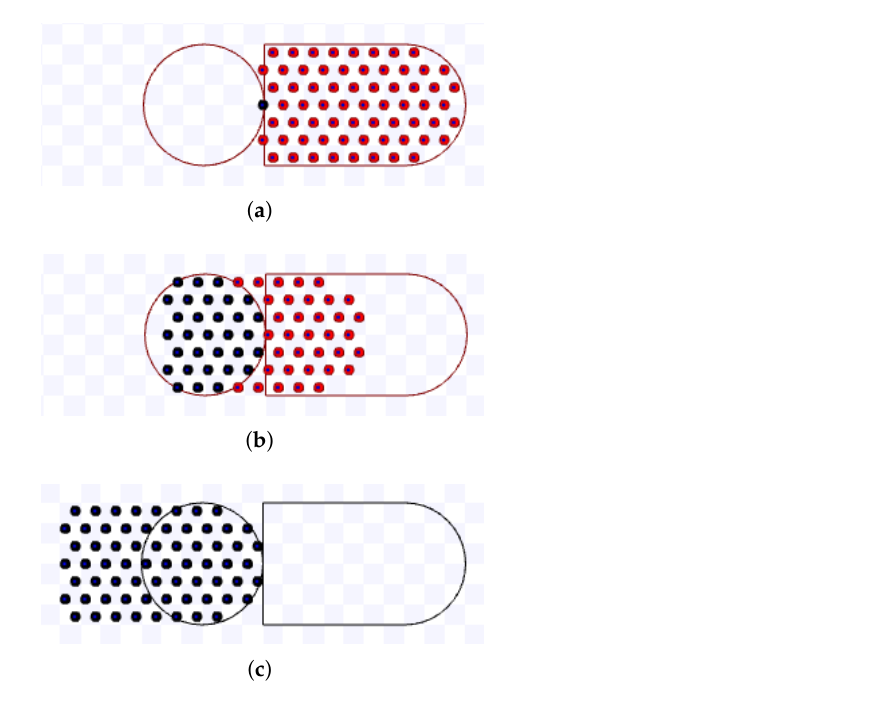
Figure 26. Simulation on Stage for hexagonal packing strategy using s = 3 m, θ = 0 during T = 9.8 s. Available on https://youtu.be/6_LgZWFOWd0, accessed on 12 June 2022. ( a ) 0 s: beginning of the simulation; ( b ) After 4.9 s; ( c ) 9.8 s: ending of the simulation.